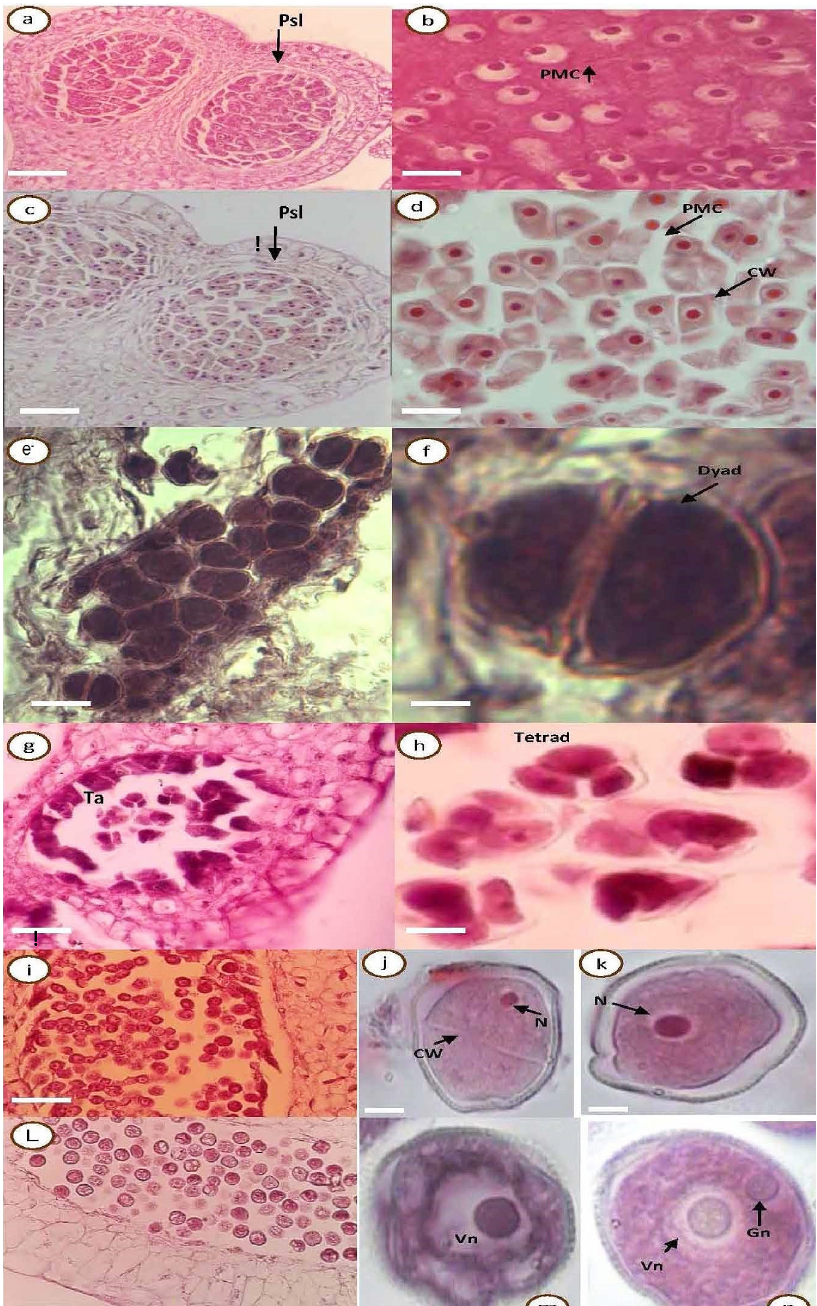
Fig. 2: Developmental stages of anther and pollen grains in F. excelsior . a) Cross section of a pollen sac containing pollen mother cells (PMC); b) Stages of PMC; c, d) the sections of anther shows two pollen sacs in pollen mother cells surrounded by a callosic wall (Cw); e, f) pollen sac in the dyad stages; g, h), tetrahedral tetrad. i-l) mononuclear microspores. m-p), mature pollen grains from different views a vegetative nucleus and two spermal nuclei. Abbreviations : psl, pollen sac layers; Ta, Tapetum layer; PMC, pollen mother cells; Cw, callosic wall; vn, vegetative nucleus; gn, generative nucleus; N, nuclei. (a) Scale bar 50 μm, (b) Scale bar 15 μm, (c, d) Scale bars 50 and 15 μm, (e, f) Scale bars 25 and 8 μm, (g, h), Scale bar 20 and 8 μm, (i-l). Scale bars 15, 11and 6 μm (m-p), Scale bars 15, 11and 6